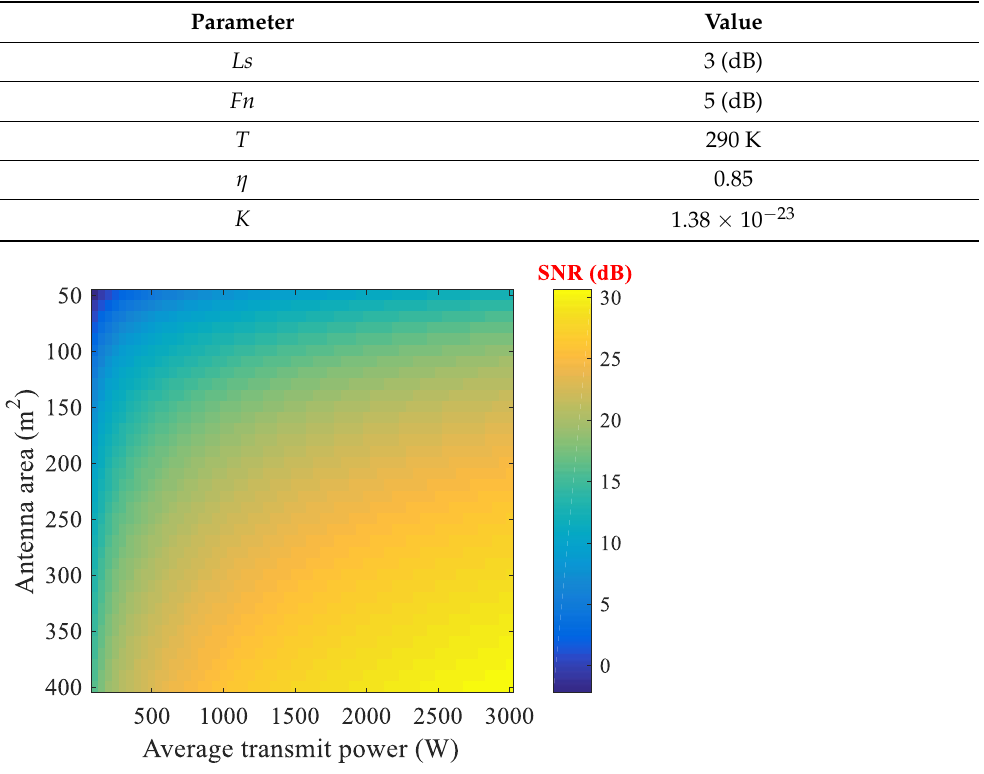
Figure 12. Relationships between target’s SNR and radar’s average transmit power and antenna power.